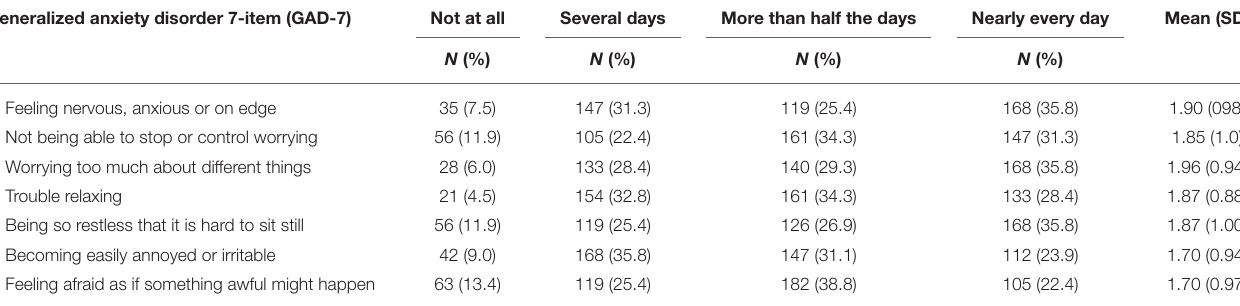
TABLE 3 | Distribution of the anxiety psychological responses of nurses toward caring for critically ill patients with COVID-19. Generalized anxiety disorder 7-item (GAD-7) Not at